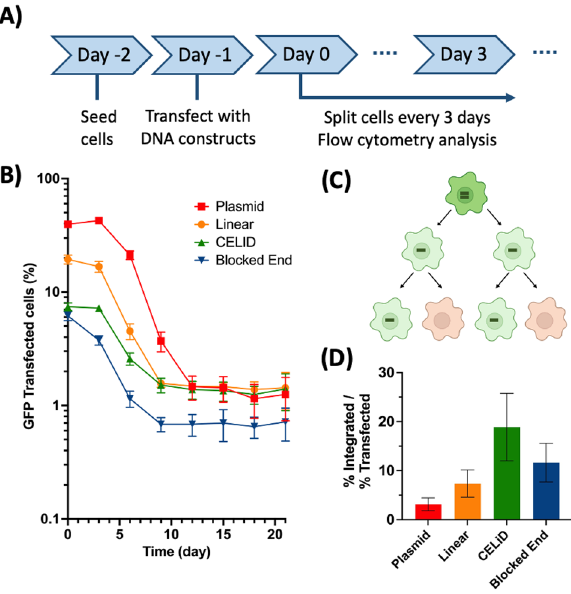
Figure 3. Comparing chromosomal integration rate of various DNA structures upon transfection into HEK293 cells. ( A ) Steps in the experiment. ( B ) Decrease in percentage of GFP expressing cells over time. Cells were split and analyzed by flow cytometry every 3 days until day 21. ( C ) Cartoon showing the segregation of transiently transfected DNAs during cell growth in an absence of drug selection. ( D ) Normalized integration frequency represented by (% GFP positive cells at day 21) / (% GFP positive cells at day